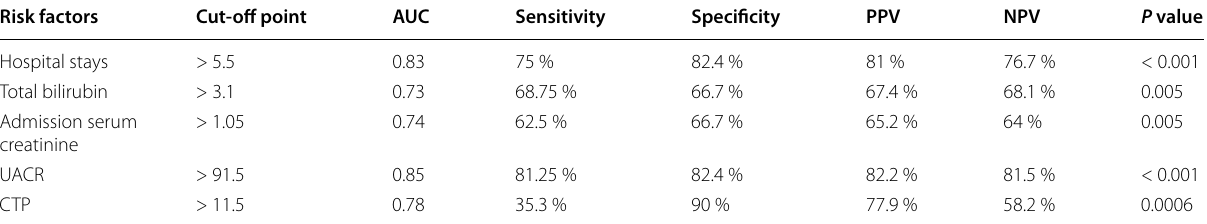
PPV positive predictive value, AUC the area under receiver curve, NPV negative predictive value